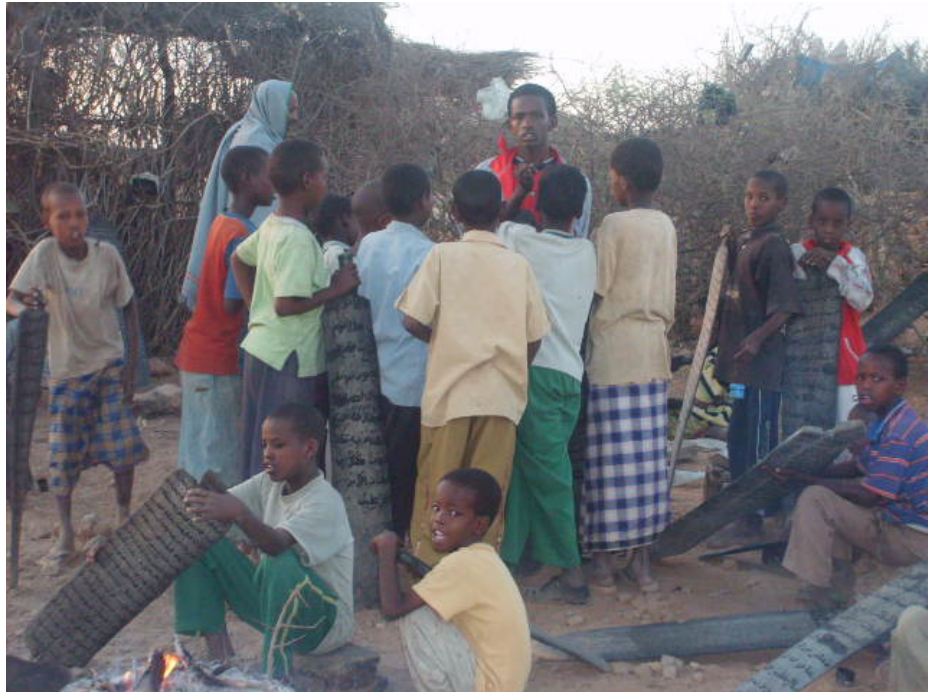
Figure 2. Children learning Qur’an in dugsi/mal’amat using loox that is made out of wood. On the top left, there is the ma’alin (Qur’anic teacher) wearing blue Go’ (men’s wraparound). On the top in the middle there is kabiir (ma’alin assistant) (Source: Author’s Register).